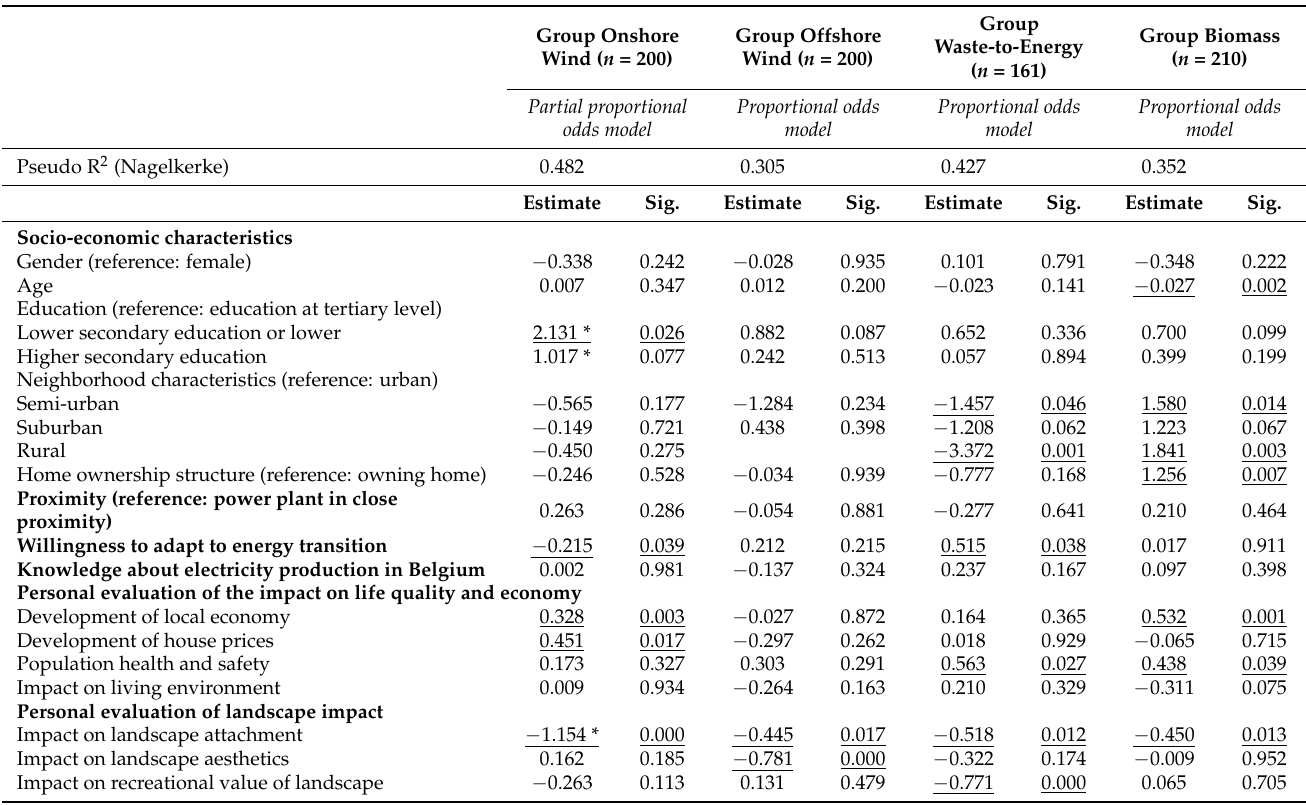
Table 3. Ordinal regression models to predict the general attitude towards the neighboring